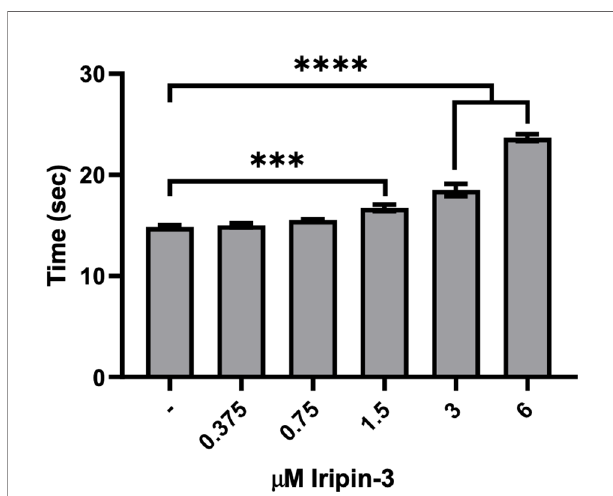
FIGURE 6 | Iripin-3 inhibits the extrinsic pathway of blood coagulation. Human plasma was treated with no Iripin-3 or with 0.375, 0.75, 1.5, 3, and 6 m M Iripin-3 and the time required for blood clot formation in the prothrombin time assay was subsequently determined on a coagulometer. Data are presented as mean ± SEM of three independent experiments (***p < 0.001, ****p < 0.0001).